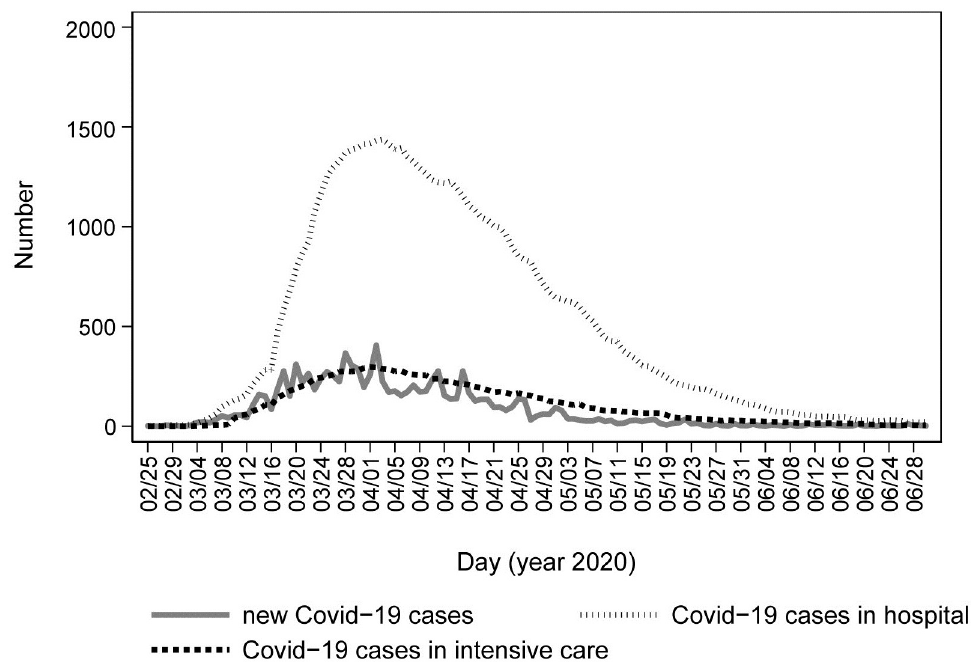
Fig 1. Number of COVID-19 cases registered in the general population of Tuscany Region during the first pandemic wave (January—June 2020).